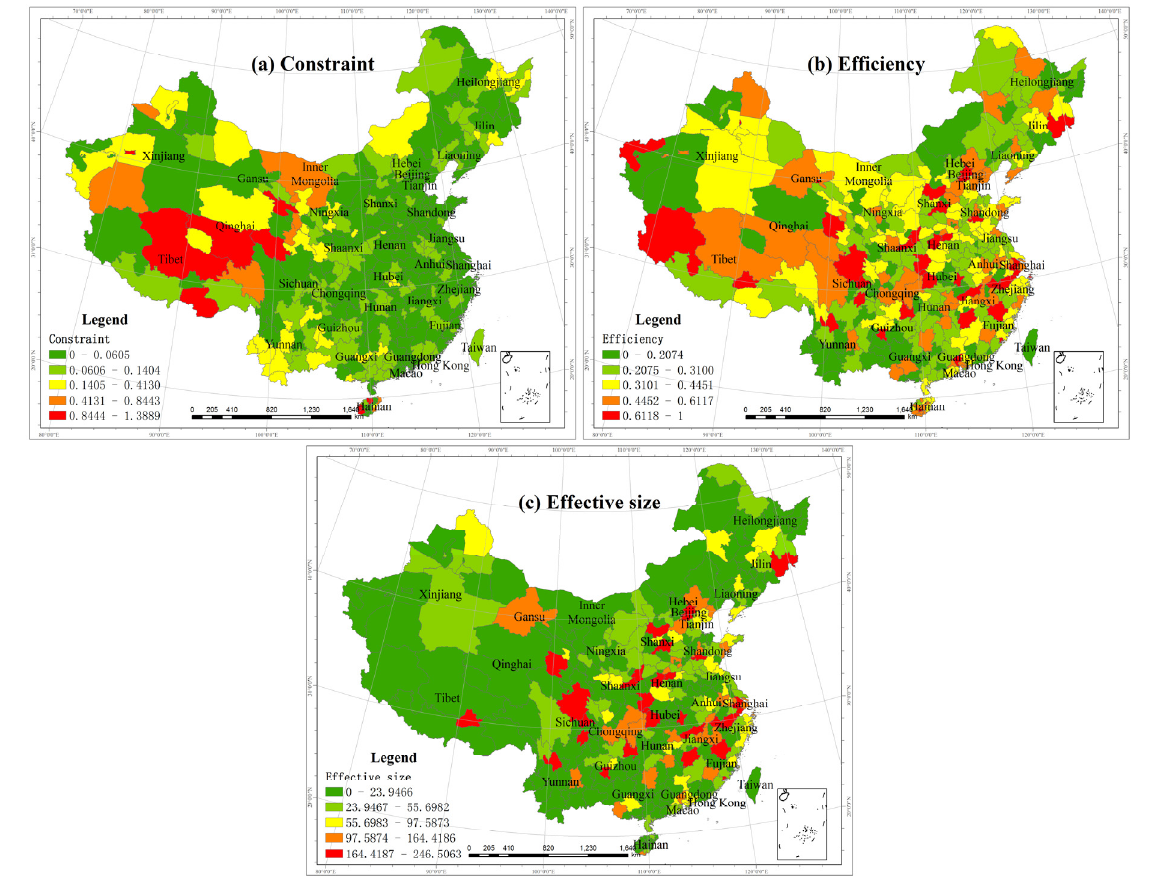
Figure 10. Distribution structural holes index of the tourism information flows in